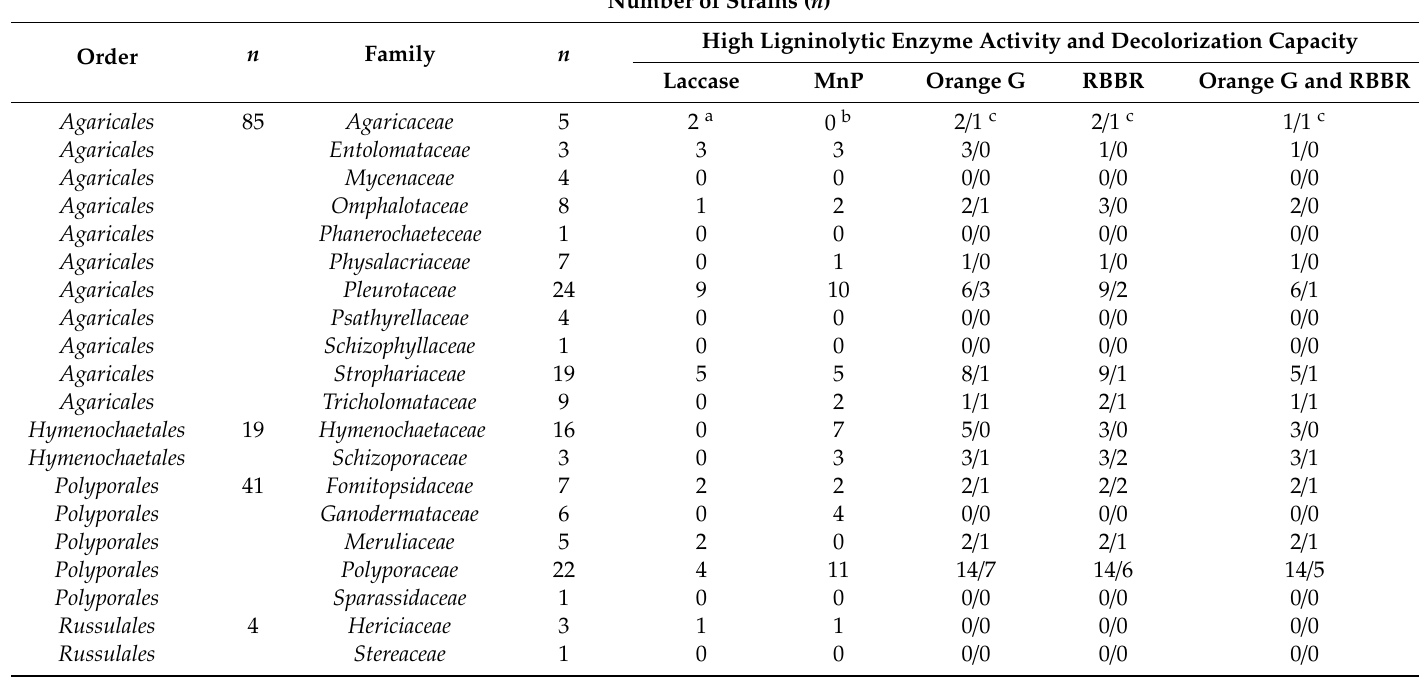
Table 5. Distribution of the strains with high decolorization capacity and with high ligninolytic enzyme production with respect to their taxonomic classification. Number of Strains ( n ) High Ligninolytic Enzyme Activity and Decolorization Capacity Order n Family n Laccase MnP Orange G RBBR Orange G and RBBR Agaricales 85